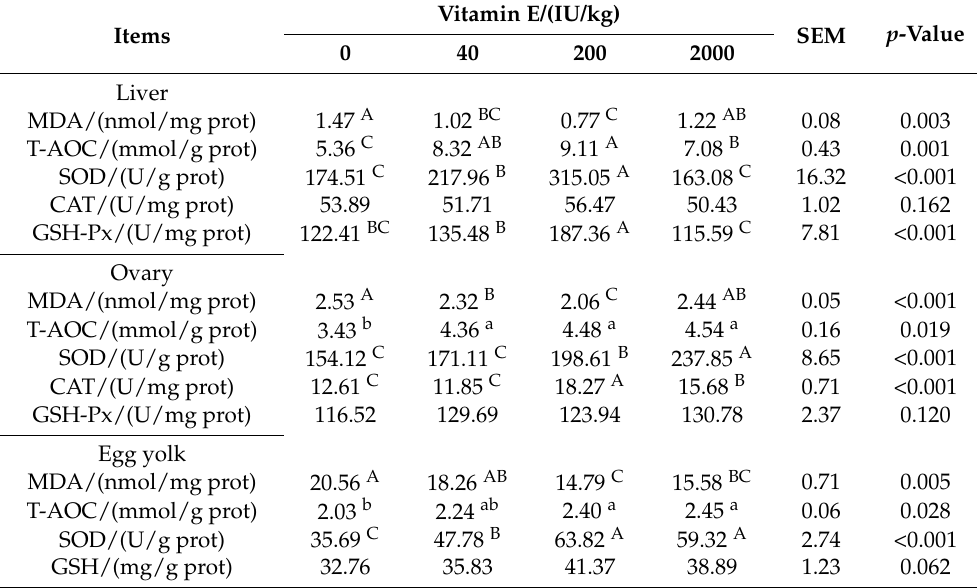
Table 7. Effects of dietary vitamin E supplementation on antioxidant capacity in breeding geese 1 .